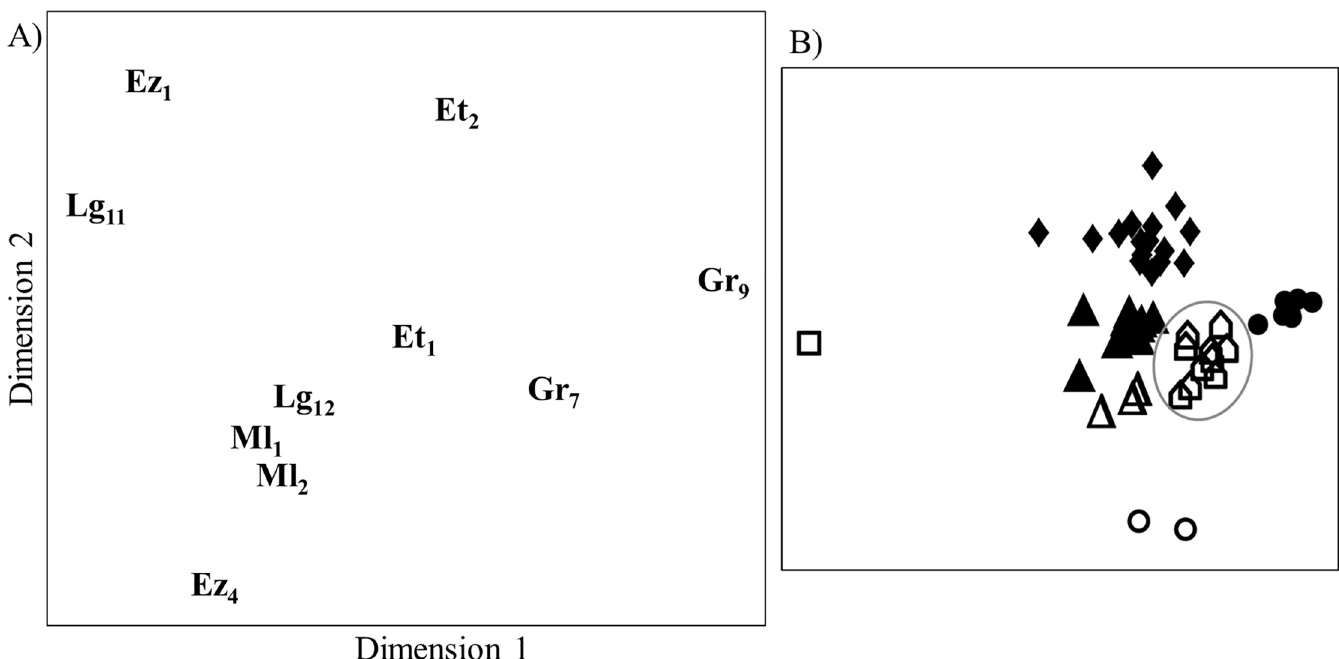
Fig 7. Similarity in chemical composition of propolis samples from 10 colonies of five different apiaries/sites (A) and propolis samples in relation to bee- collected resin types (B). Letters indicate different apiaries/sites (for meanings of abbreviations see Table 1), numbers mark different colonies. Ordination Figures are based on Bray-Curtis dissimilarities between samples (stress value = 0.07). Different symbols in B) represent different resin types: closed circle: “brown”; closed diamond: “ocher”; closed triangle: “orange”; open triangle: “red”; open circle: “clear”; open square: “whitish”.